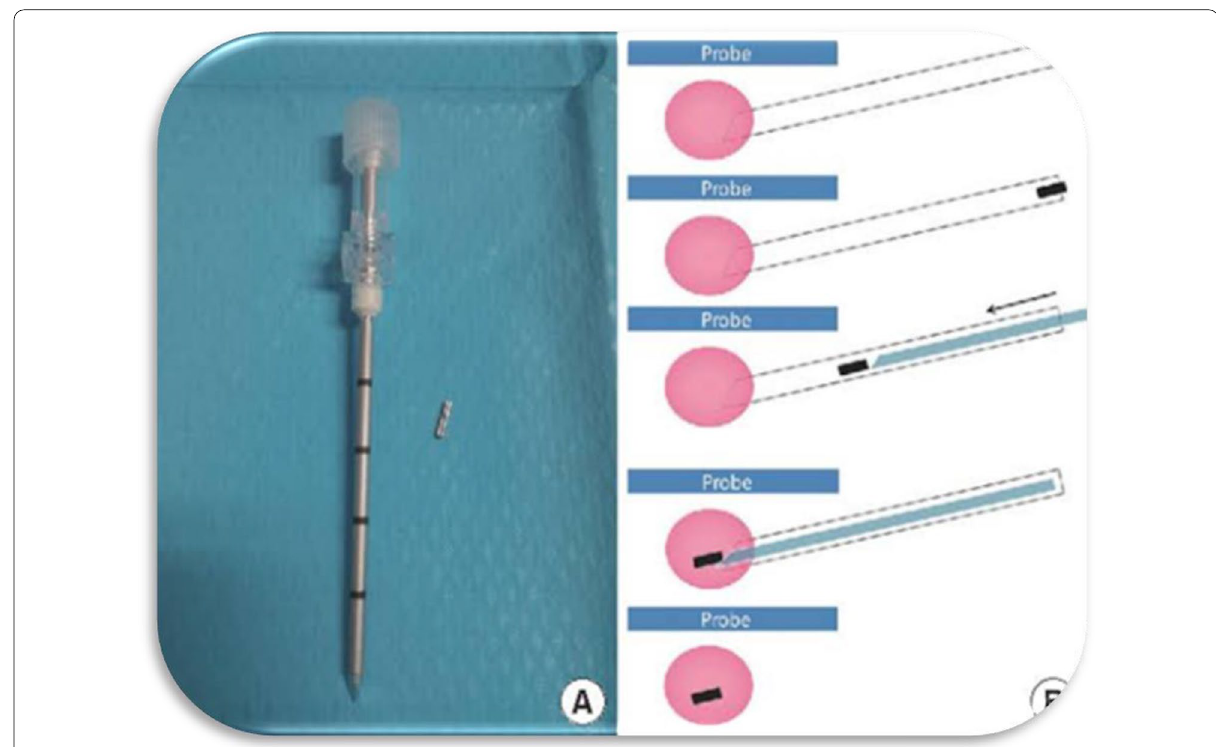
Fig. 2 Schematic diagram of the preoperative ultrasonography (US) guided surgical clip insertion. A The coaxial guiding needle with an inner stylet and surgical clips. B Under US-guidance (blue), the coaxial guiding needle (white) is inserted into the center of the breast cancer (pink), and one or two clips (black) are passed through. The inner stylet (light blue) is reinserted for pushing the clip (Quoted from Young et al. [1])